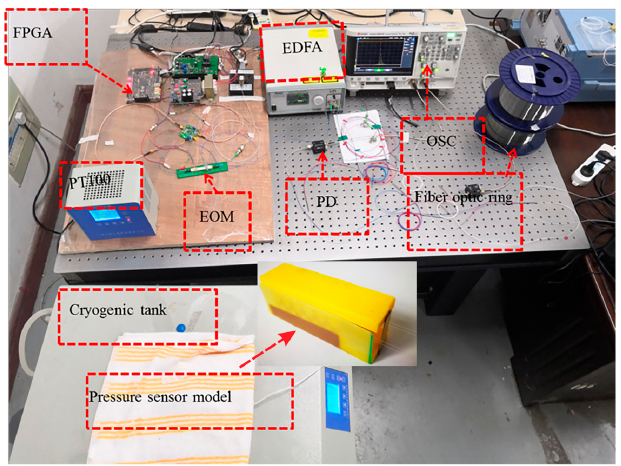
Figure 7. The picture of static ice pressure sensor